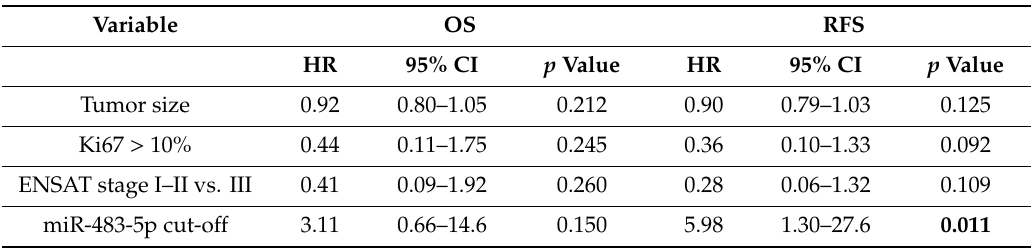
Table 3. Multivariate analysis (Cox regression) of circulating miR-483-5p and clinicopathological parameters in relation to overall survival (OS) and recurrence-free survival